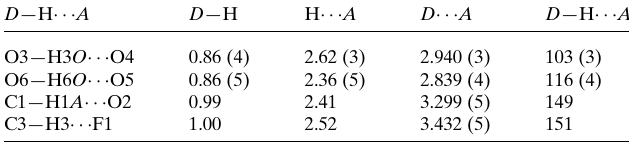
Table 2 Suspected O—H (cid:2)(cid:2)(cid:2) A and C—H (cid:2)(cid:2)(cid:2) A contacts (A˚ , (cid:3) ). D —H (cid:2)(cid:2)(cid:2) A